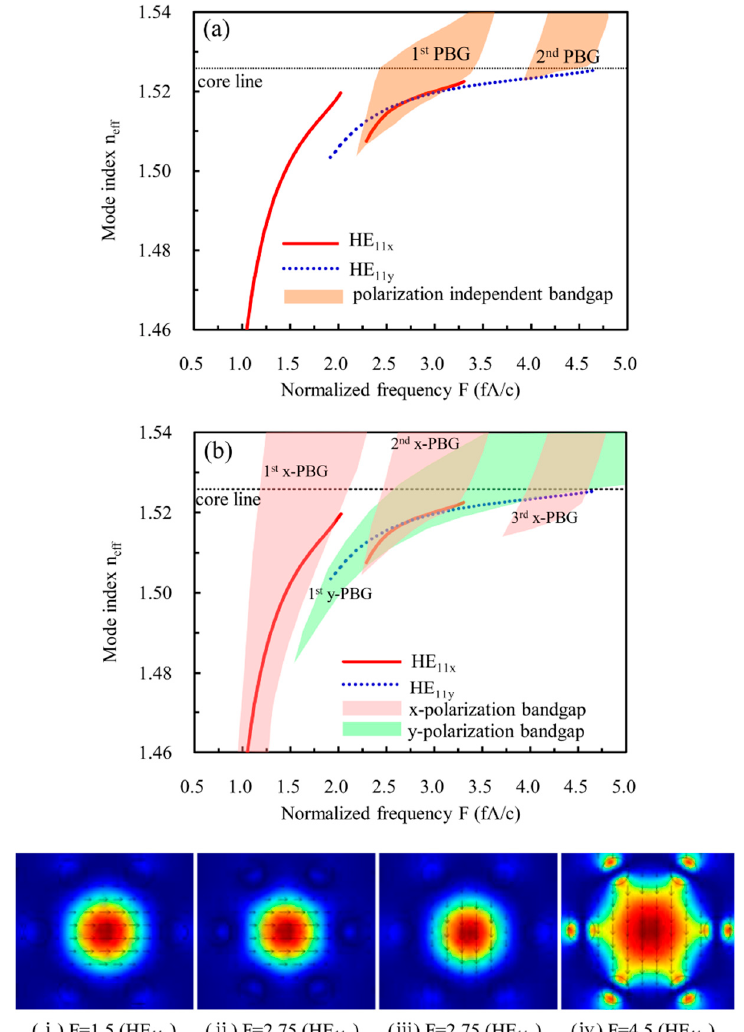
Figure 3. Bandgaps and modal dispersion curves for polarized fundamental modes HE 11x (solid red line) and HE 11y (dotted blue line) of the THz LC-MOF ( d / Λ = 0.4) with rotation angle of the LC director φ = 0. ( a ) Polarization-independent total bandgaps, ( b ) polarization-dependent bandgaps. Bottom: mode profiles and transverse electric-field distributions (arrow diagram).